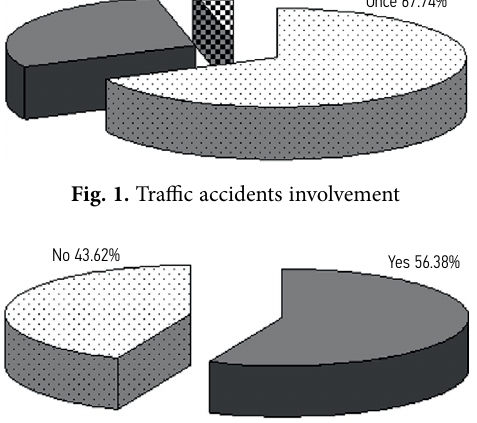
Fig. 2. Driving under the influence of